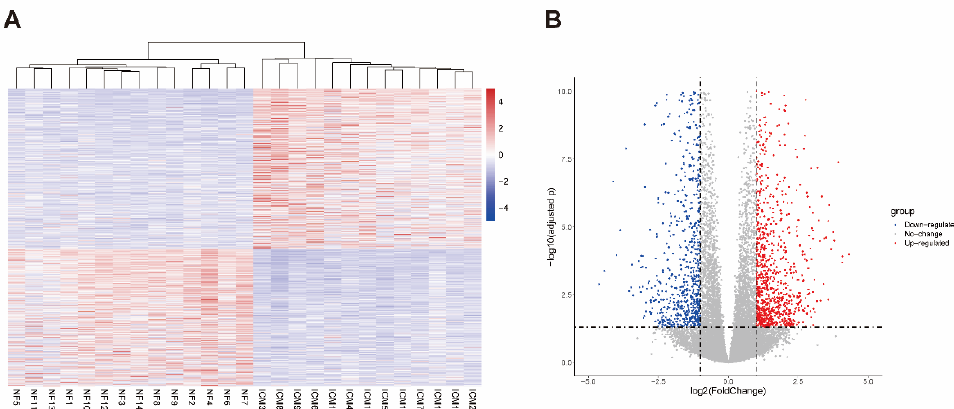
Figure 1. Heatmap and volcano plot to visualize differentially expressed genes identified in the GSE116250 dataset. ( A ) Heatmap of all DEGs. ( B ) Volcano plot. ICM, ischemic cardiomyopathy; NF, non-failing heart; DEGs, differentially expressed genes.